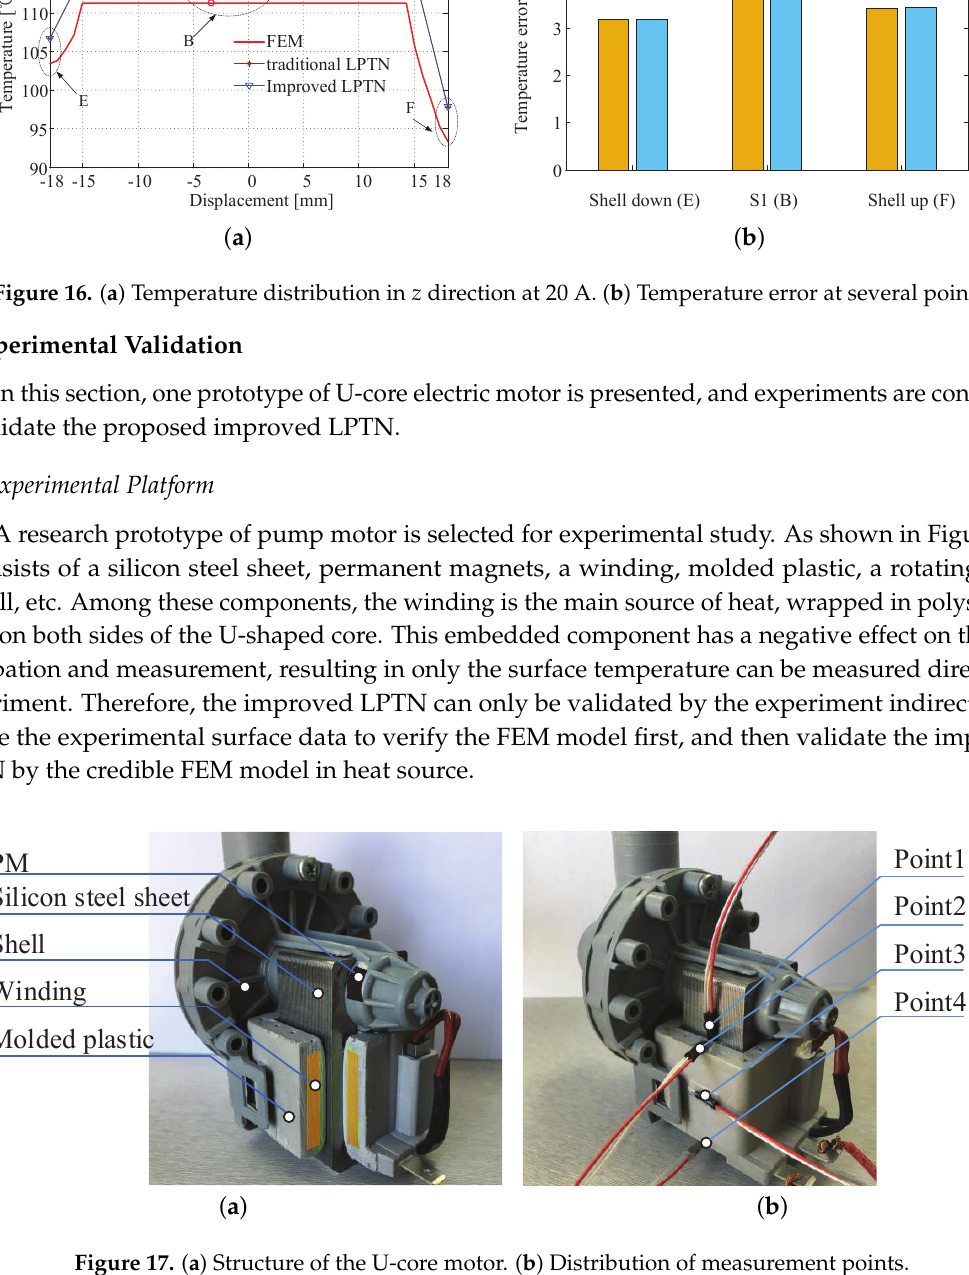
Figure 17. ( a ) Structure of the U-core motor. ( b ) Distribution of measurement